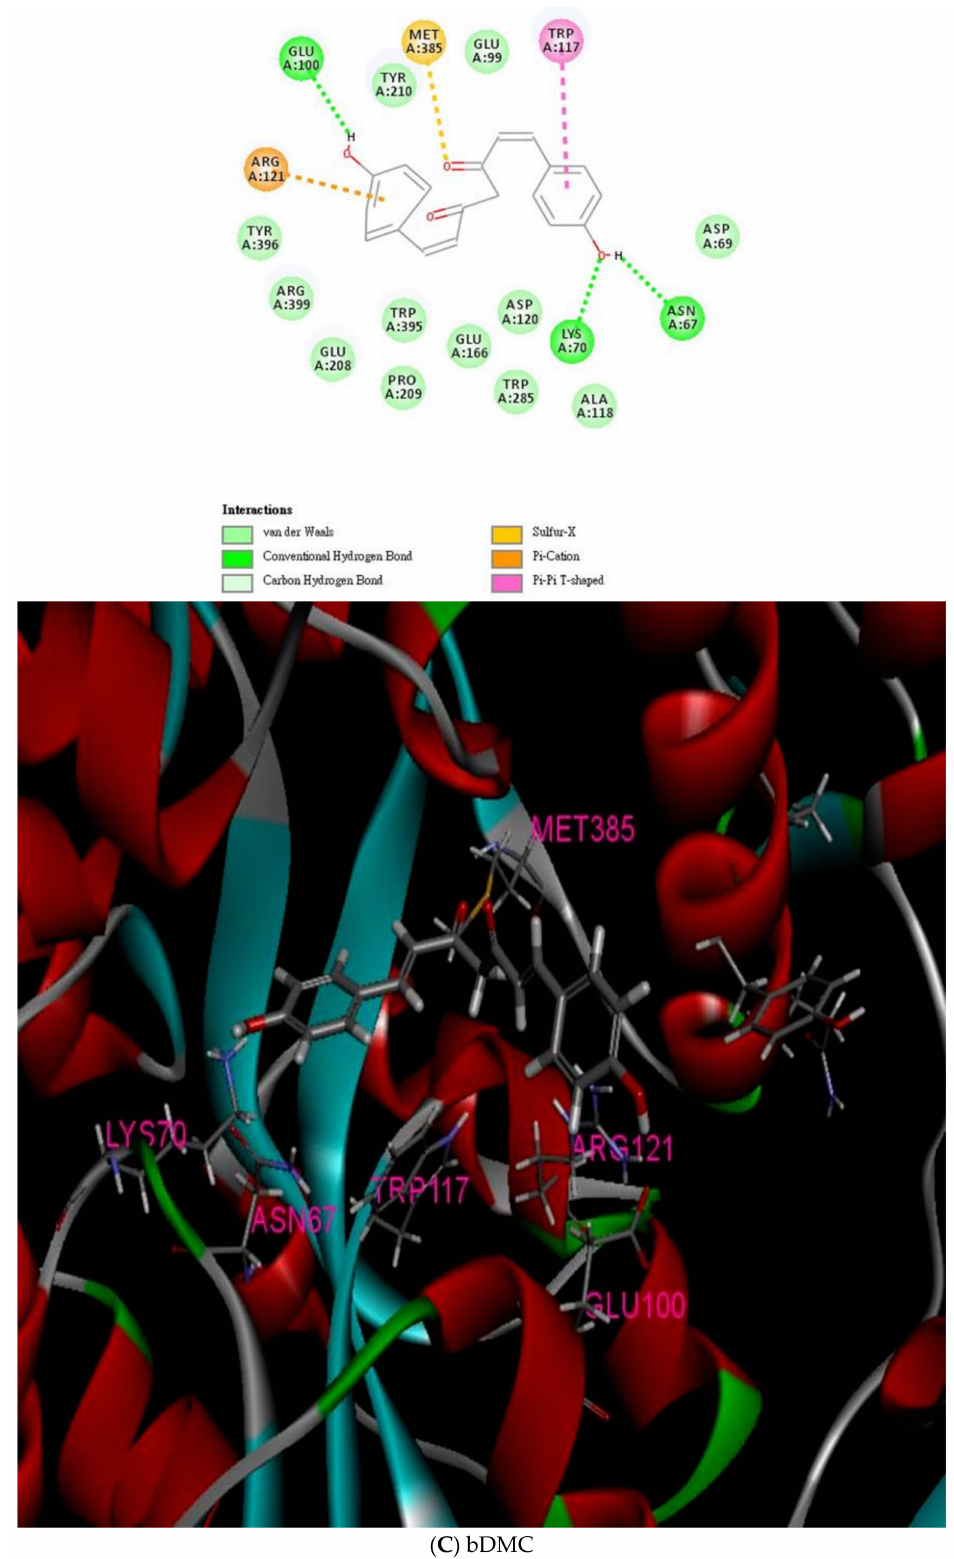
Figure 1. Binding mode of the interactions between curcuminoids (i.e., curcumin, DMC, and bDMC) and the endoglin residues. ( A ) Left panel: interaction between curcumin and endoglin (2D visualiza- tion). Right panel: interaction between curcumin and endoglin adduct (3D visualization). ( B ) Left panel: interaction between DMC and endoglin (2D visualization). Right panel: interaction